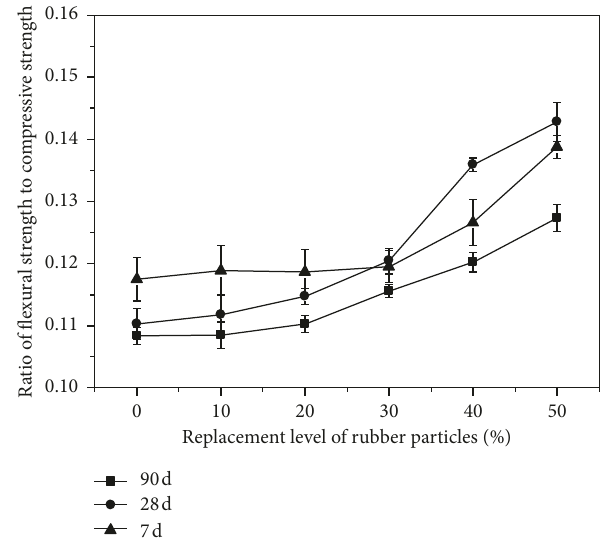
Figure 25: Flexural strength of SCRLC versus replacement level of rubber particles.